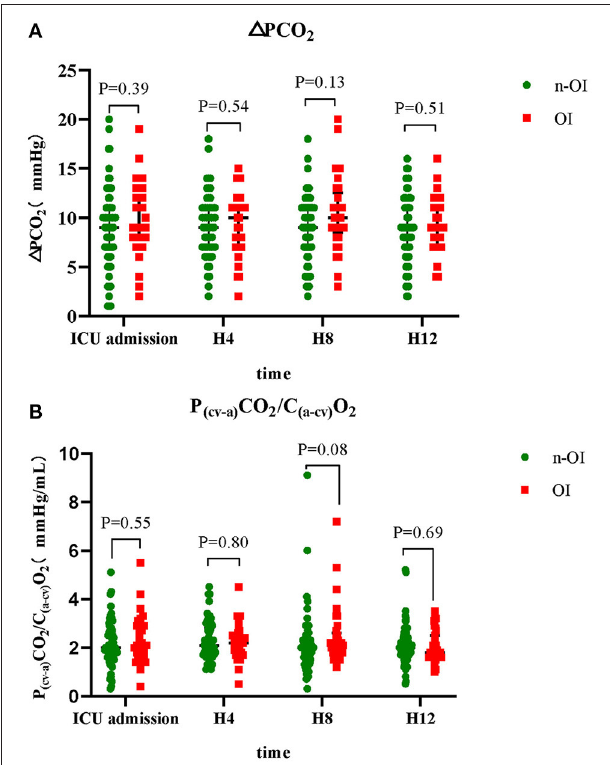
FIGURE 2 | Dynamic changes of carbon dioxide-derived variables of n-OI and OI groups at the four time points. (A) central venous-to-arterial carbon dioxide difference ( 1 PCO 2 ) (B) 1 PCO 2 to arterial-central venous oxygen content difference rate ( 1 PCO 2 /C (a − cv) O 2 ). GraphPad prism version 8.0.2 statistical software was used to construct box charts (median with interquartile range). The Mann–Whitney U test was used for intergroup comparison.